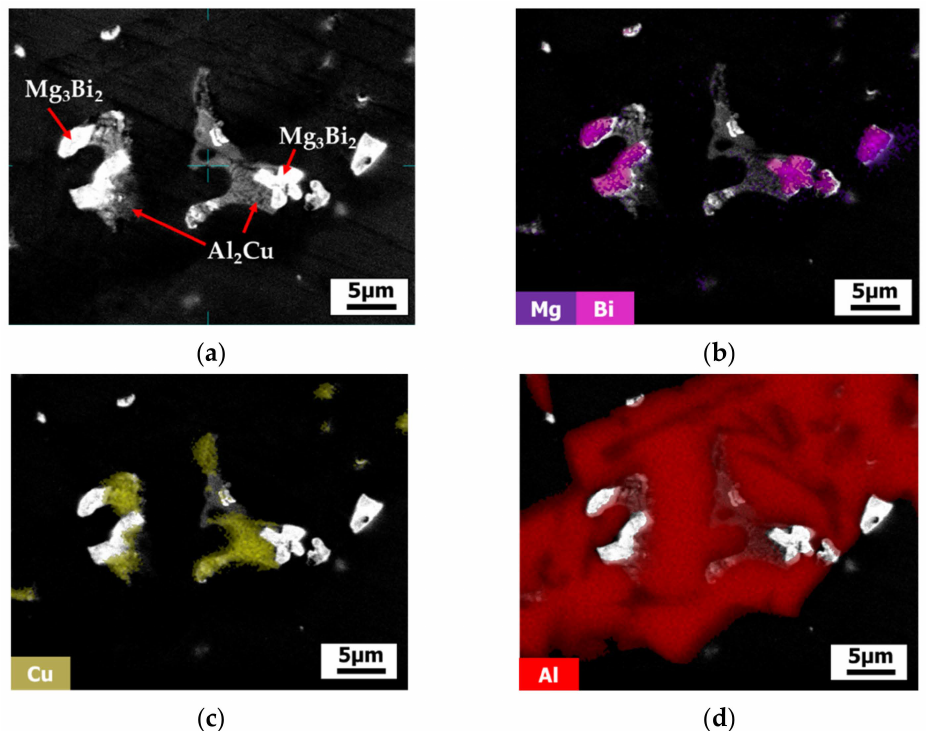
Figure 12. Elemental mapping shows on B390-1.0%wt Bi ( a ) Mg 3 Bi 2 and Al 2 Cu ( b ) elemental mapping of Mg and Bi ( c ) elemental mapping of Cu, and ( d ) elemental mapping of Al.